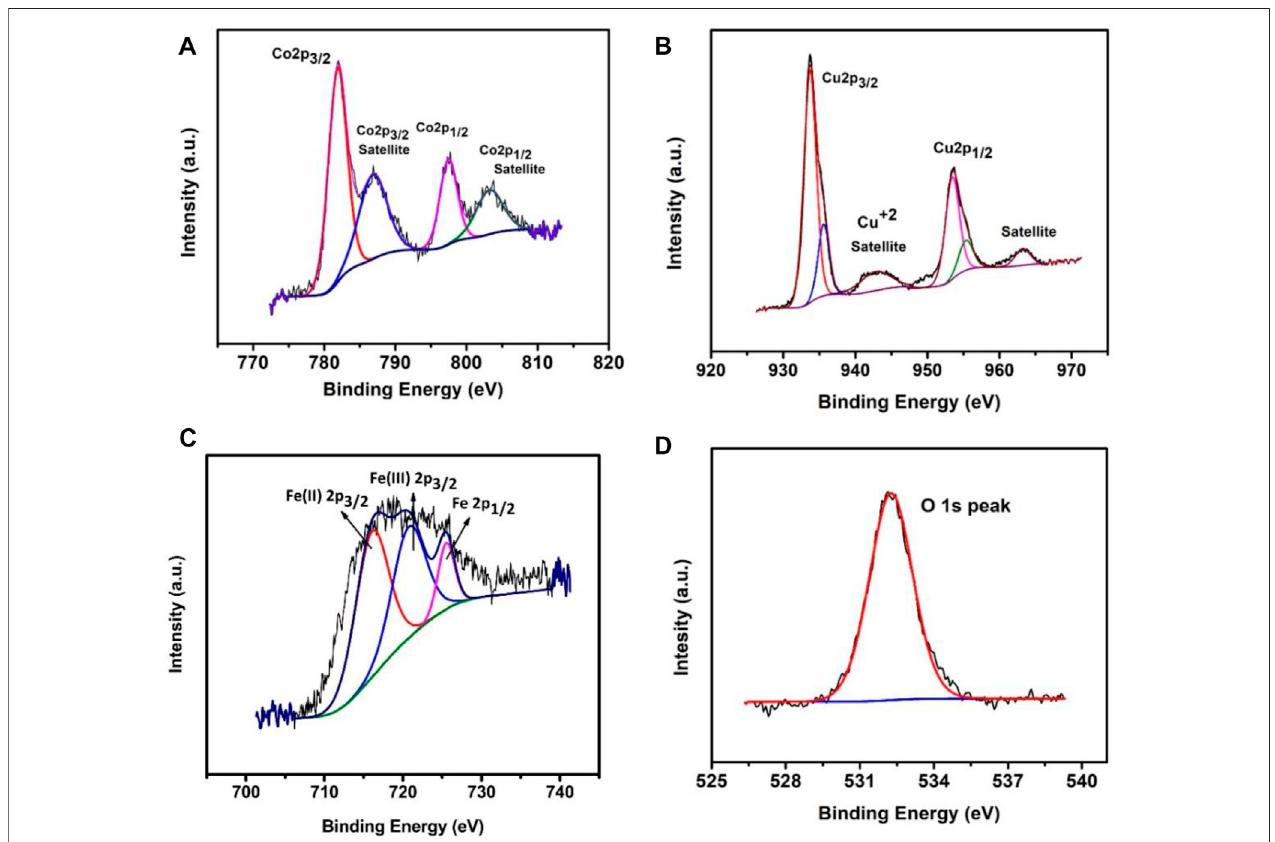
FIGURE 3 | The X-ray photoelectron spectroscopy (XPS) spectra: Co 2p (A) , Cu 2p (B) , Fe 2p (C) , and O 1s (D) .